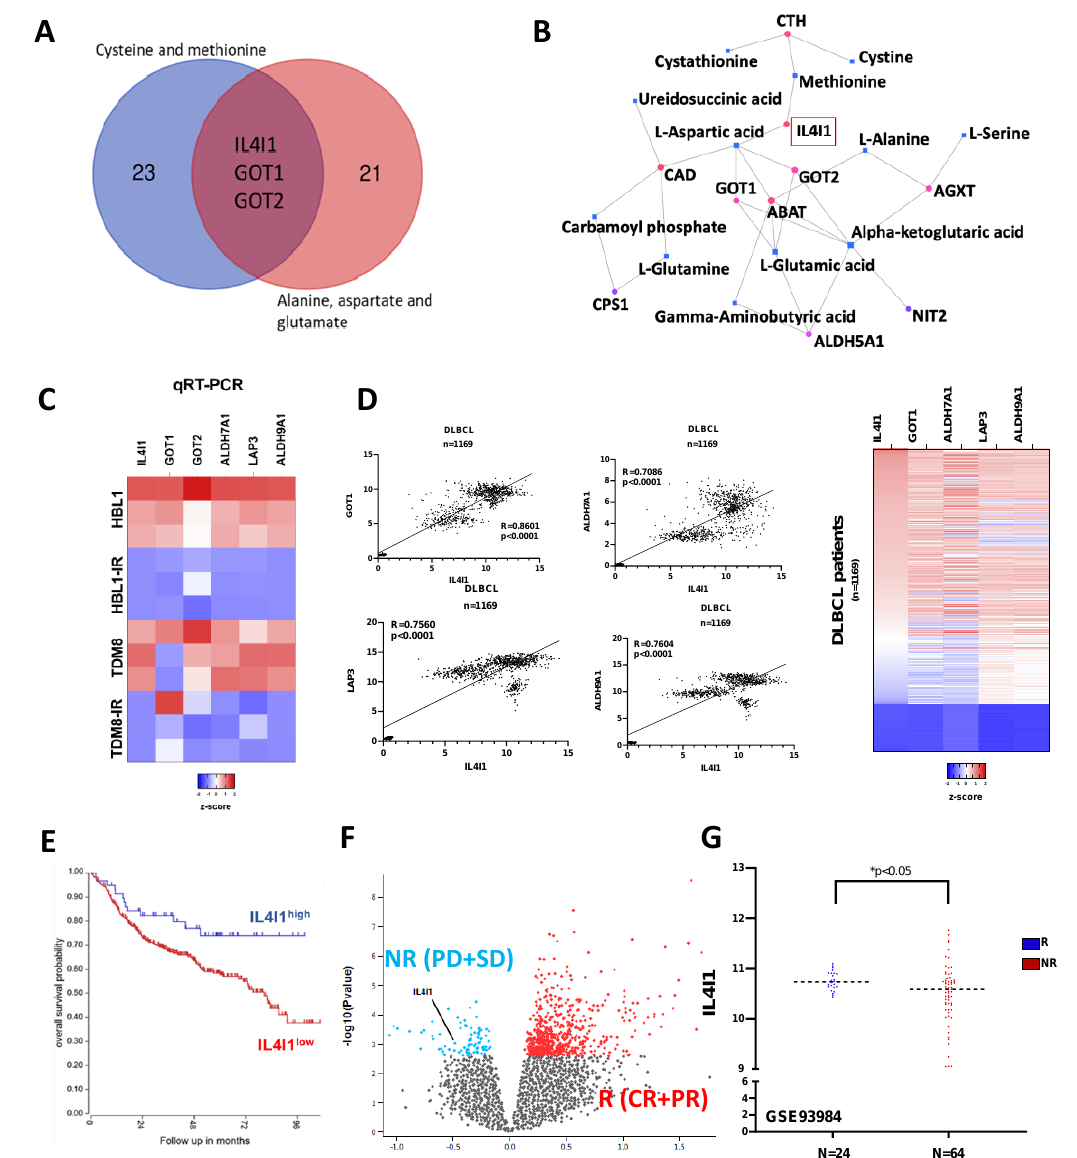
Figure 3. Integration of metabolic genes highlight IL4I1. ( A ) Overlap of the genes pertaining to each metabolic pathway revealed IL4I1, GOT1, and GOT2 to be at the crosstalk of these pathways. ( B ) Proposed interaction map of transcriptomic and metabolomic data, regulated by IL4I1. ( C ) q-PCR quantification of the genes of interest in lymphomas to validate expression in ABC-DLBCL ibrutinib-resistant cells. ( D ) Correlation plot and heatmap of the IL4I1 with the key metabolic genes in the 1169 DLBCL patients. ( E ) Kaplan-Meier survival analysis of DLBCL patients as determined from GSE31312 and analyzed by R2: Genomics Analysis and Visualization Platform. ( F ) Volcano showing the IL4I1 low levels in ABC DLBCL patients who did not respond to ibrutinib, as determined from the GSE93984. ( G ) Relative level of IL4I1 in ABC DLBCL patients who did not respond to ibrutinib.